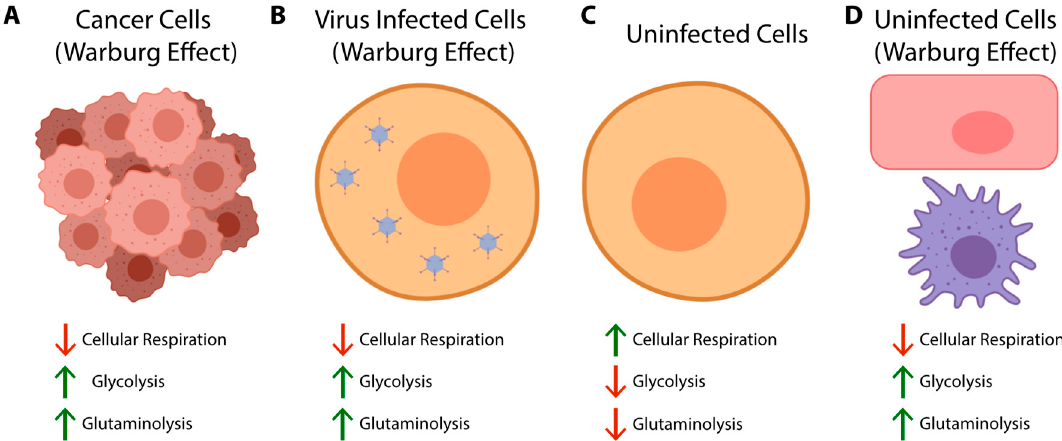
Figure 2. Both cancer cells ( A ) and virus infected cells ( B ) often exhibit a characteristic metabolic phenotype known as the Warburg effect. This phenotype is associated with an increase in cellular glycolysis and a concurrent decrease, albeit not a complete reduction, of cellular respiration despite the availability of ample oxygen. In contrast, healthy, uninfected cells ( C ) preferentially utilize cellular respiration over glycolysis as the main ATP generating pathway. Glutaminolysis is also less active in uninfected non-transformed cells. However, there are uninfected cells ( D ) that preferentially utilize the Warburg effect. For example, endothelial cells consistently have a Warburg effect-like metabolic phenotype [19]. Activated immune cells, such as effector T cells, activated macrophages, and activated dendritic cells, also shift to a Warburg effect-like metabolic phenotype [20]. Created with BioRender.